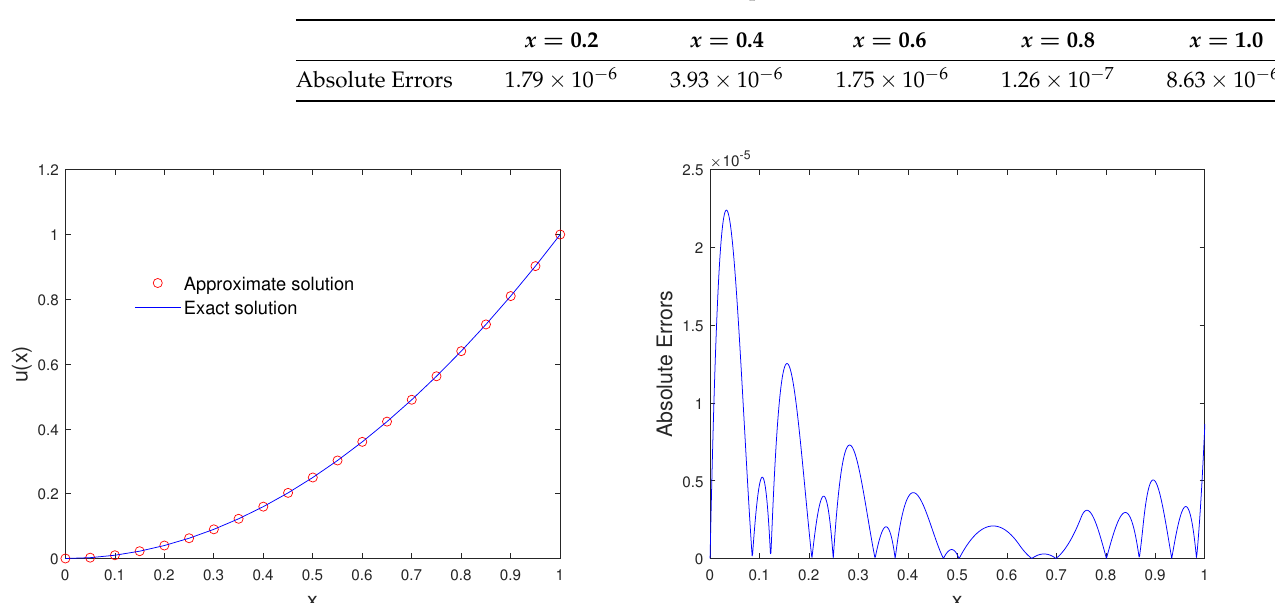
Table 4. The absolute error for s = 3 for Example 3.